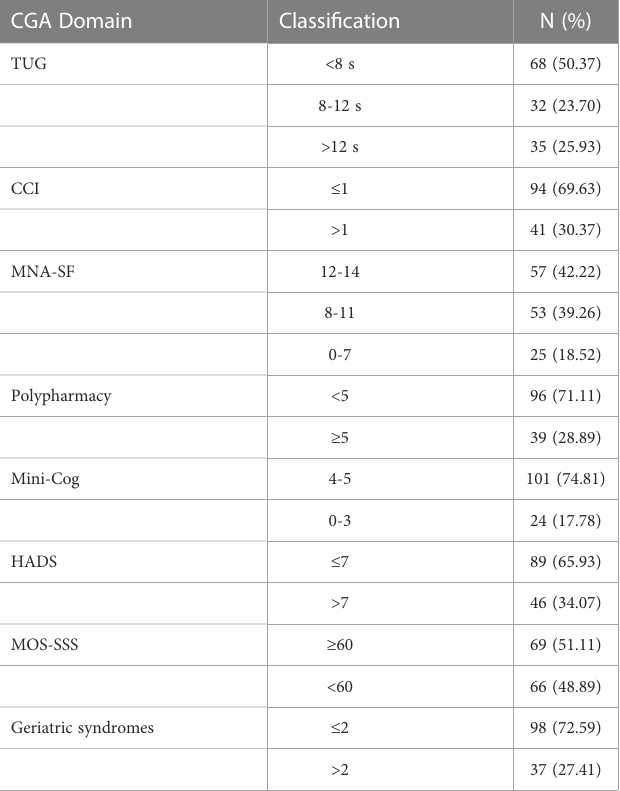
TABLE 3 Characteristics of 8 domains of the CGA (N=135).